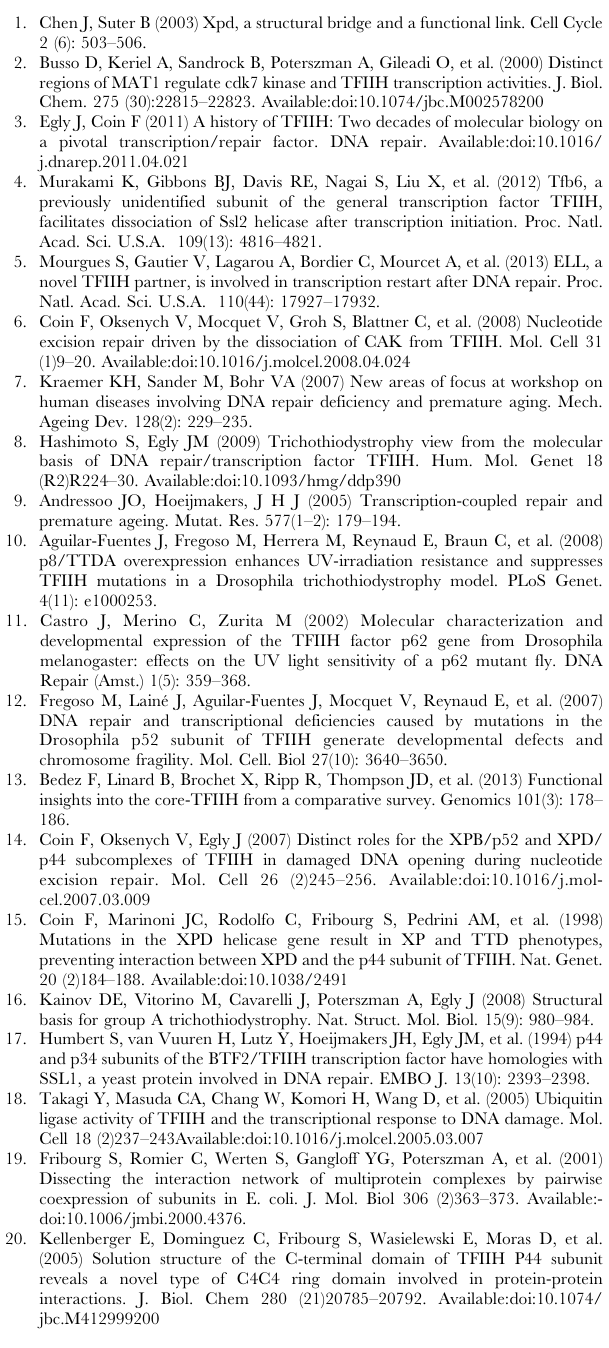
coordinating residues at each site are shown in stick representa- tion. Secondary structure elements of symmetry related molecules are indicated by a prime symbol following the a or b labeling, respectively. Figure S2 Final model and 2F o –F c electron density map of the p34ct structure. The final model of p34ct is shown in stick representation for a portion of helix a 5 (A) and the a 7 b 6 transition (B) with the 2F o –F c electron density map contoured at 1.0 sigma.